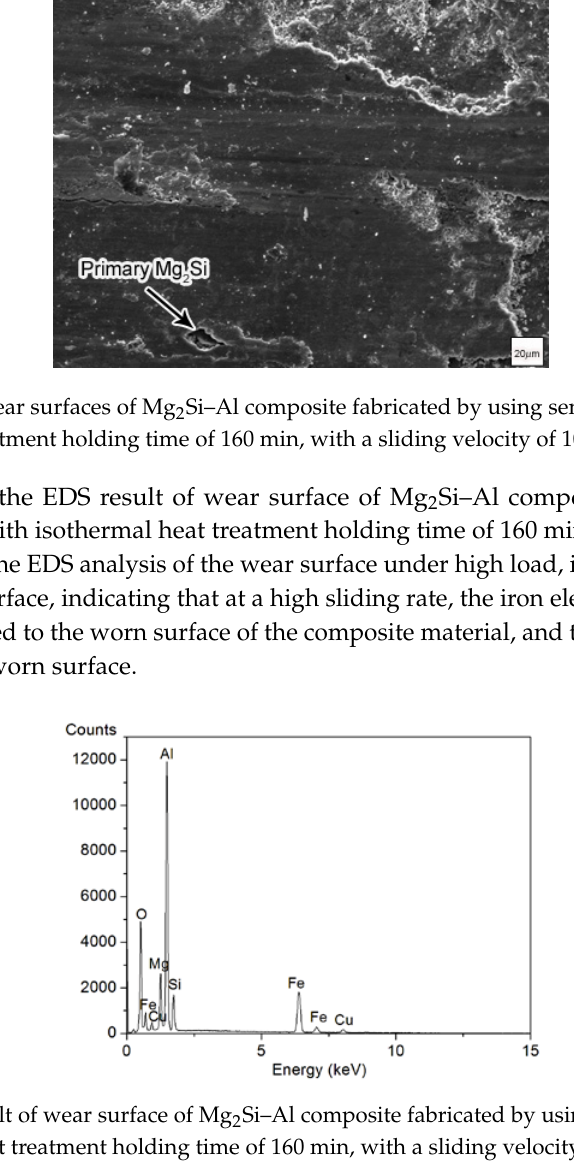
Figure 8. SEM of wear surfaces of Mg 2 Si–Al composites fabricated by using ( a ) gravity casting and semi-solid extrusion with isothermal heat treatment holding times of ( b ) 50 min, ( c ) 60 min, and ( d ) 160 min with a sliding velocity of 1000 r/min.